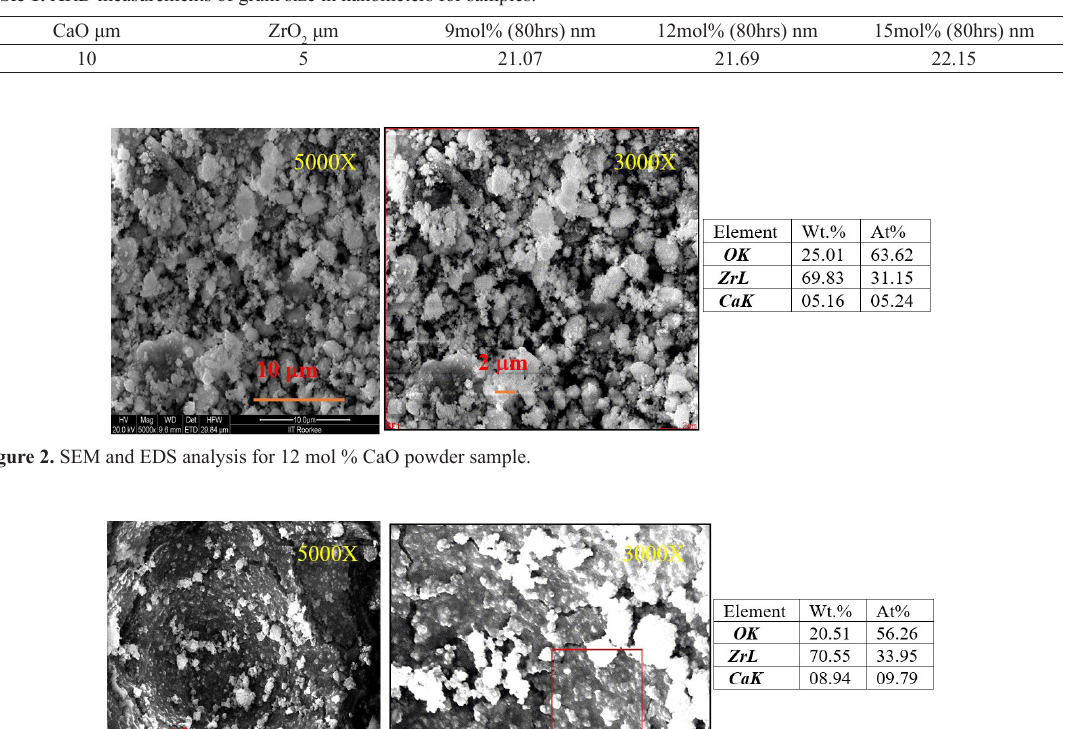
Table 1. XRD measurements of grain size in nanometers for